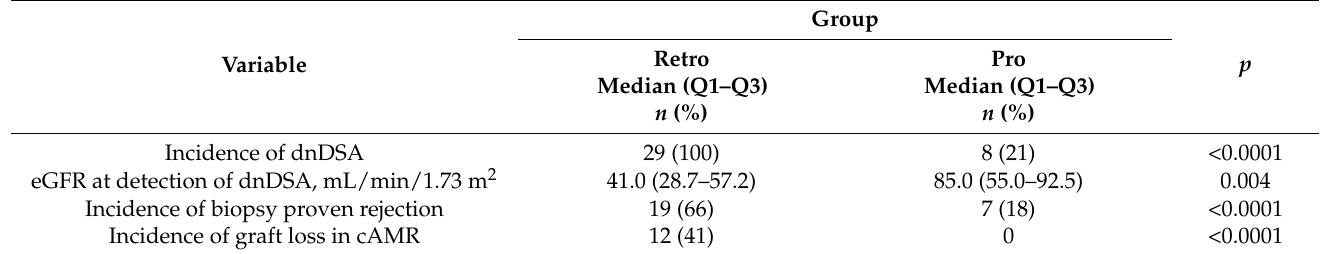
Table 3. Kidney function (eGFR), incidence of acute rejection and cAMR, in the retrospective and the prospective groups.